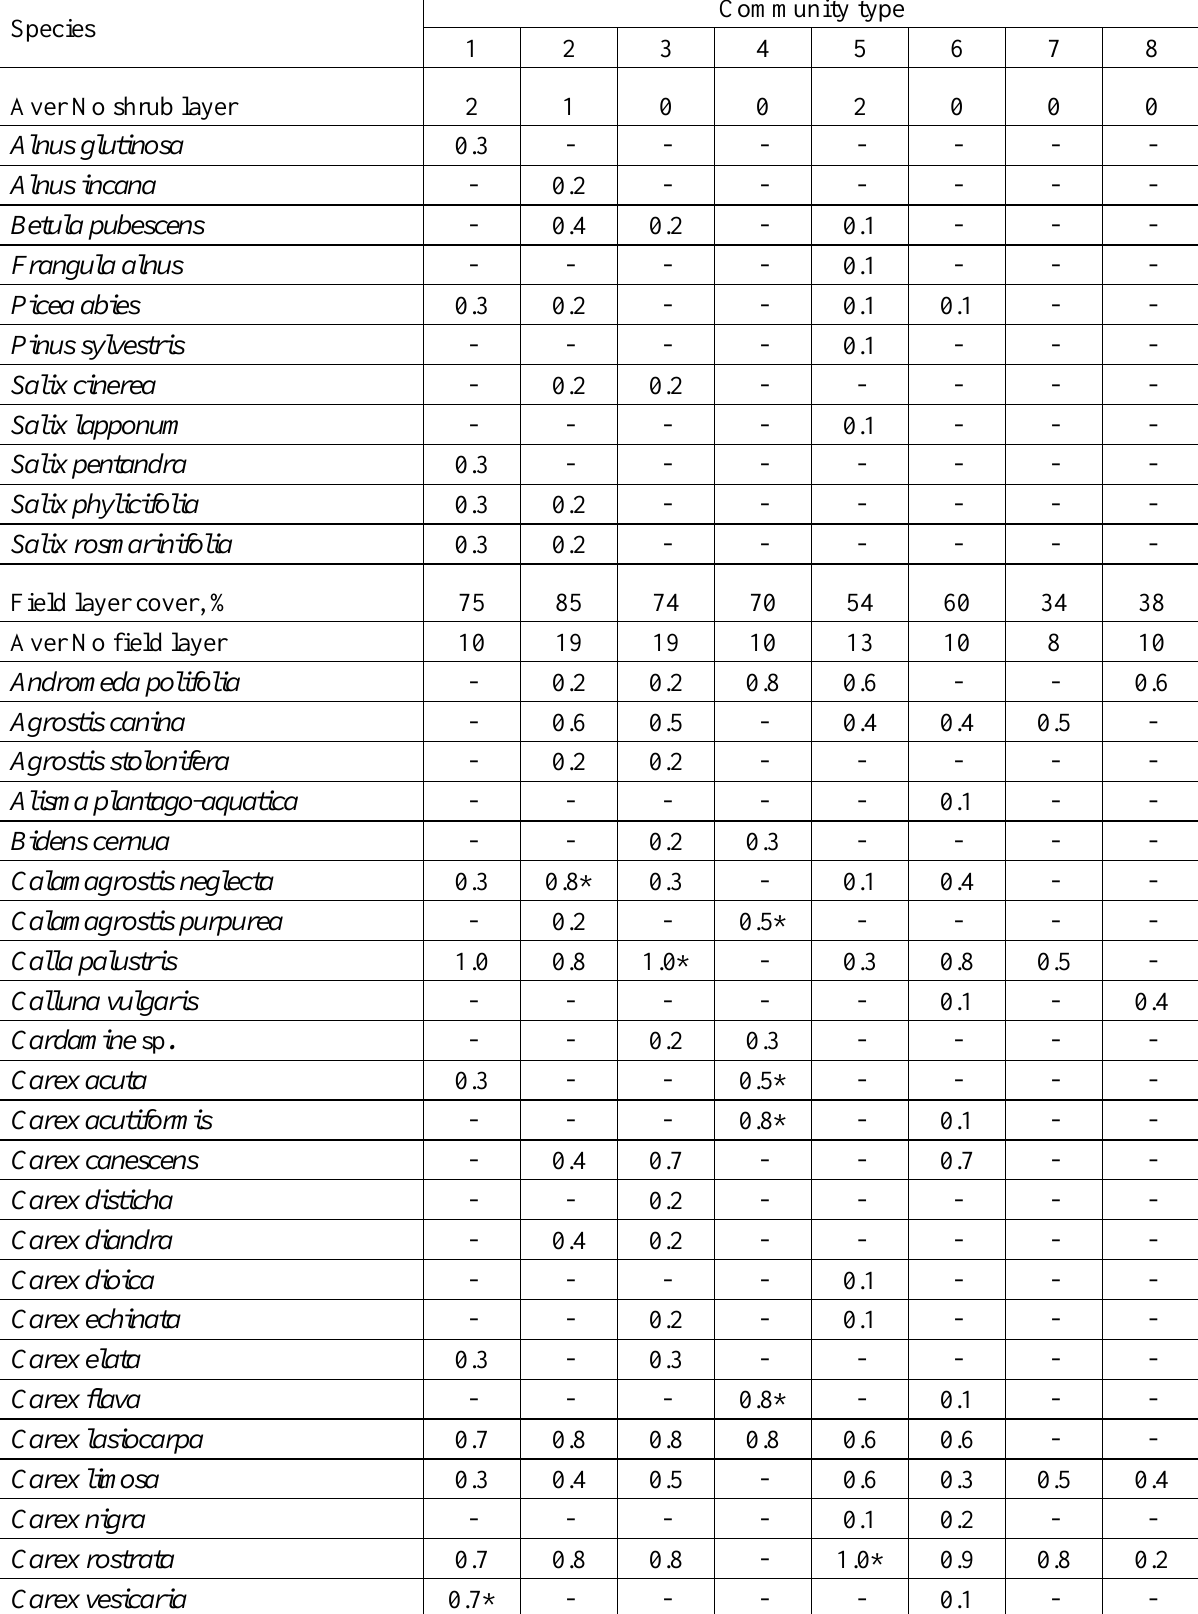
Table 7. Centroids (species frequency) of community types. Aver No = average number of species; significant (p < 0.05) indicator species are marked with asterisks